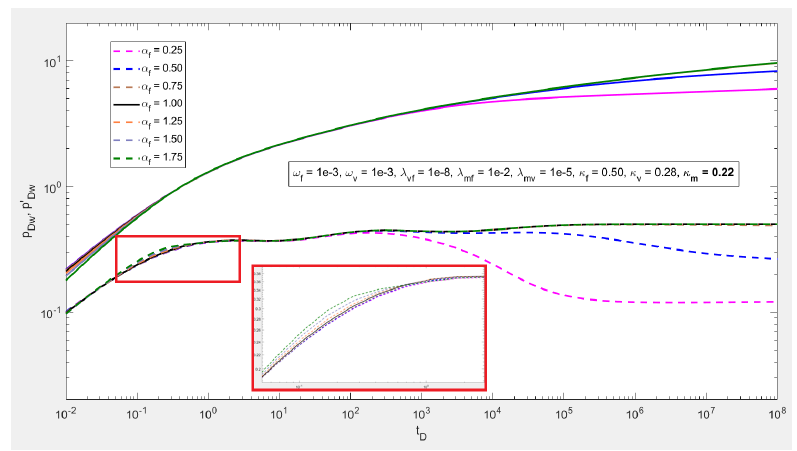
Figure 3. Effects of considering anomalous flow only in the fractured system, α v = 1, α m = 1.